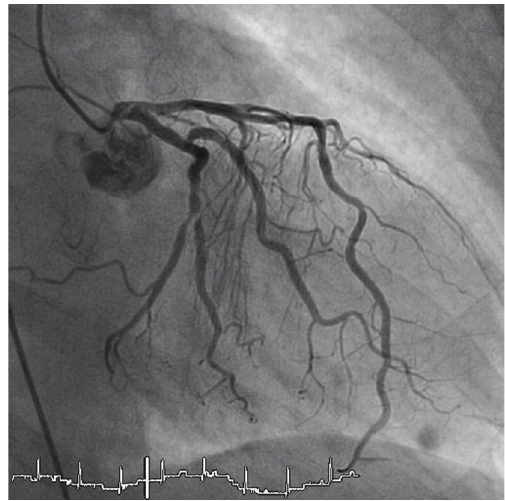
Figure 2: Coronary angiography revealing a 50% stenosis in the left anterior descending coronary artery and a subtotal occlusion (99%) of the circumflex coronary artery.